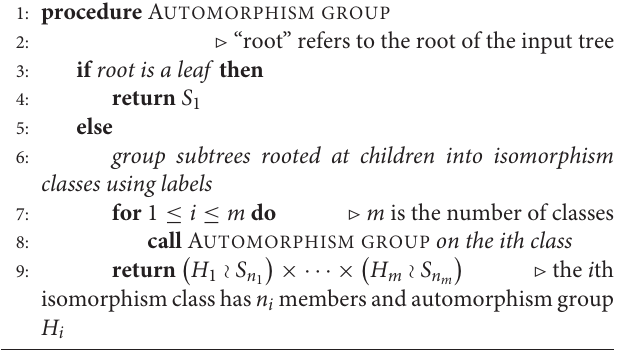
Algorithm 3 Compute the automorphism group of a rooted tree